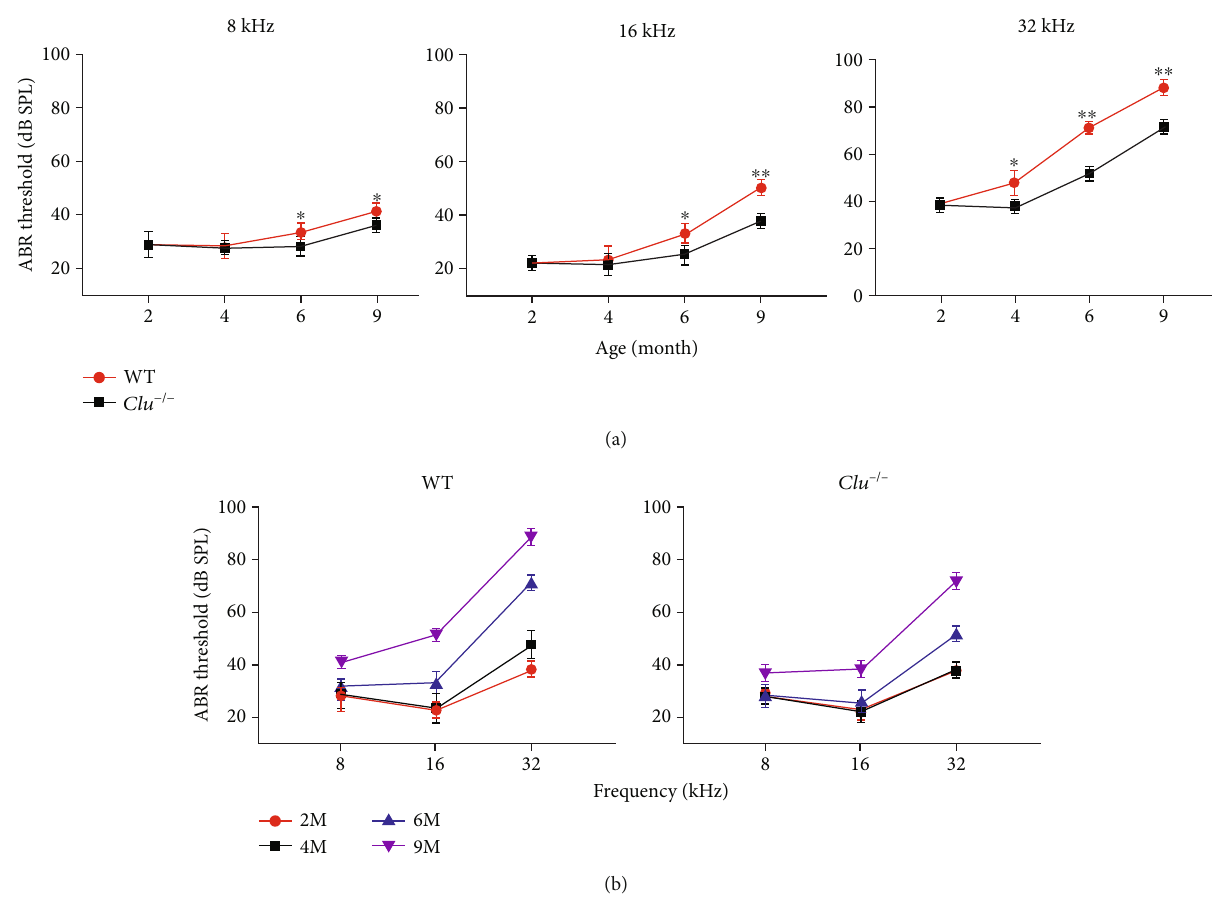
Figure 4: Assessment of age-related auditory dysfunction. (a) ABR hearing thresholds were measured at 32, 16, and 8kHz in WT and Clu − / − mice at P2m, P4m, P6m, and P9m. Clu de fi ciency delayed ARHL in C57BL/6 mice. Data are presented as the mean ± SD . ∗ p < 0 : 05 , ∗∗ p < 0 : 01 . N = 6 . (b) ABR thresholds of WT and Clu − / − mice at P2m, P4m, P6m, and P9m. N = 6